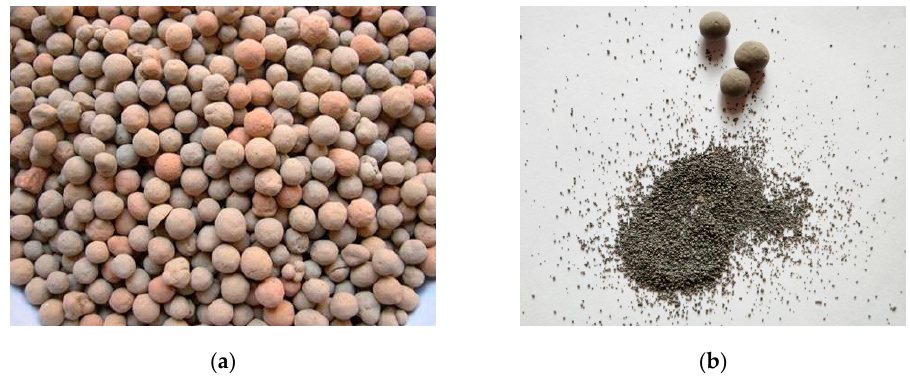
Table 4. Physical properties of single-particle gangue.